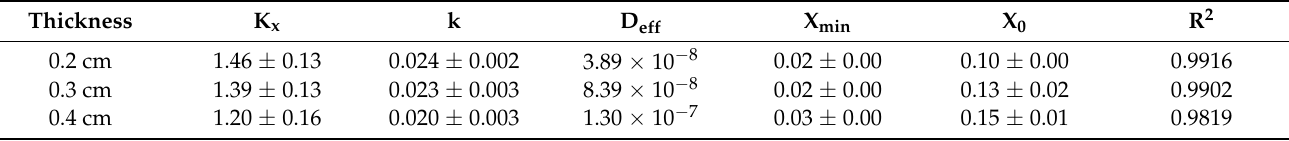
Table 2. Parameters of moisture loss in Krokida model equation for different frying thickness of pork skin. Thickness